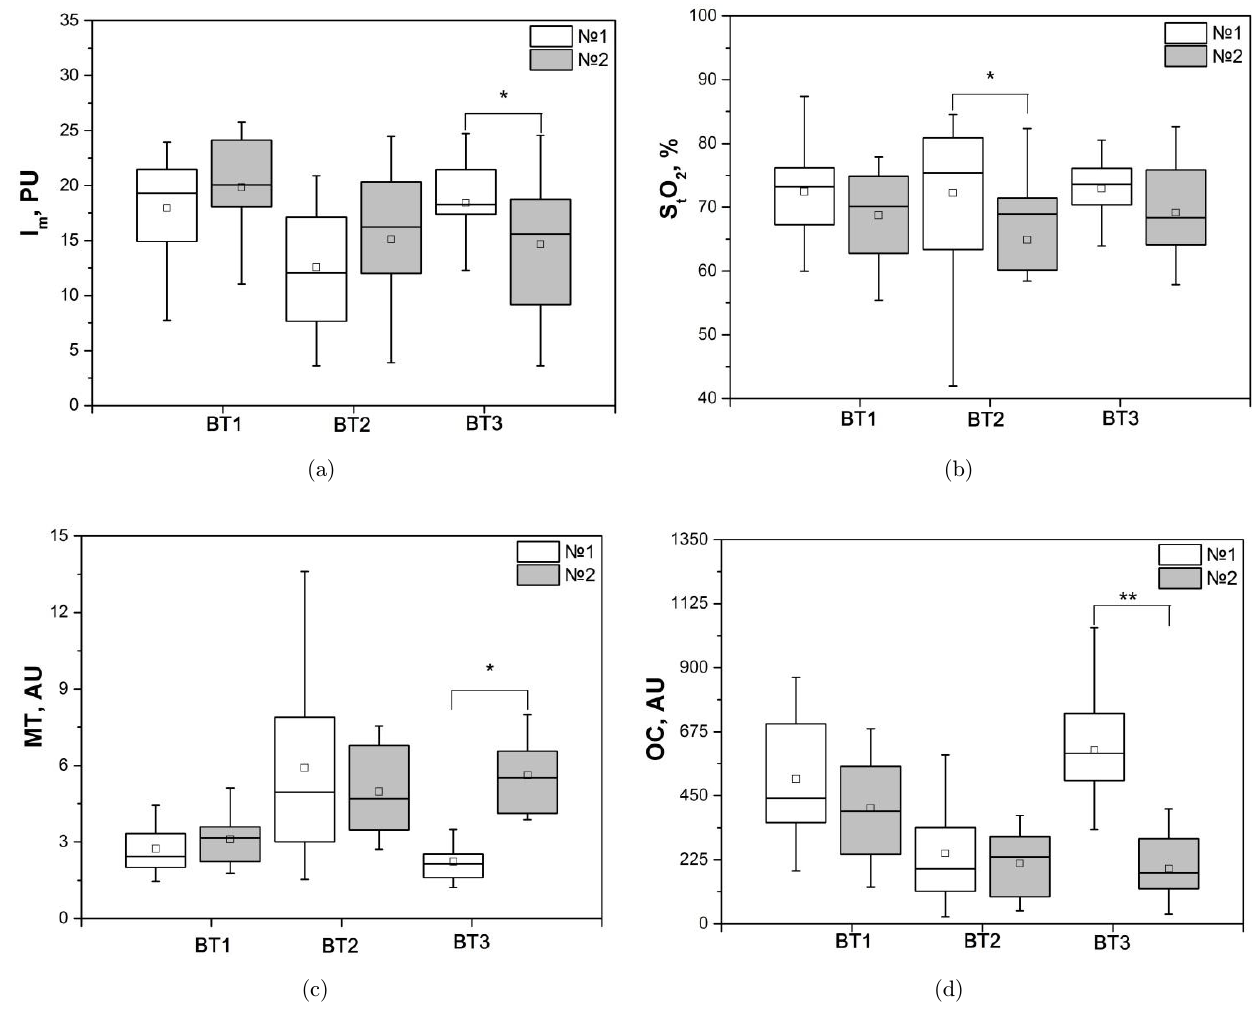
Fig. 3. The results of static analysis on healthy volunteer without angiospastic disorders (No. 1) and patient with angiospastic disorders (No. 2) data: the index of blood microcirculation (a), tissue oxygen saturation (b), myogenic tone (c) and the rate of oxygen consumption